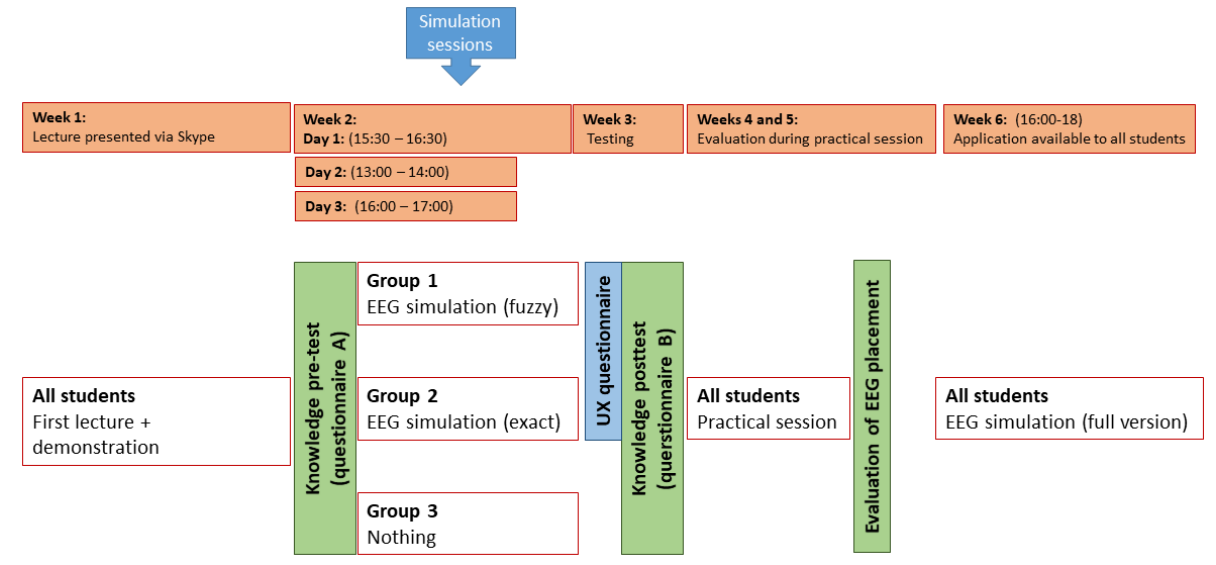
Figure 3. Time schedule for the study and data collections. EEG: electroencephalography; UX: user